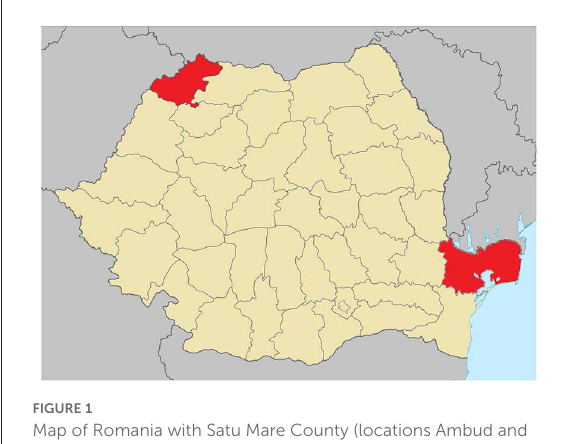
FIGURE1 Map of Romania with Satu Mare County (locations Ambud and Odoreu) highlighted in red in the Northwest and Tulcea County (locations Somova and Sˇalcioara) highlighted in red in the Southeast.